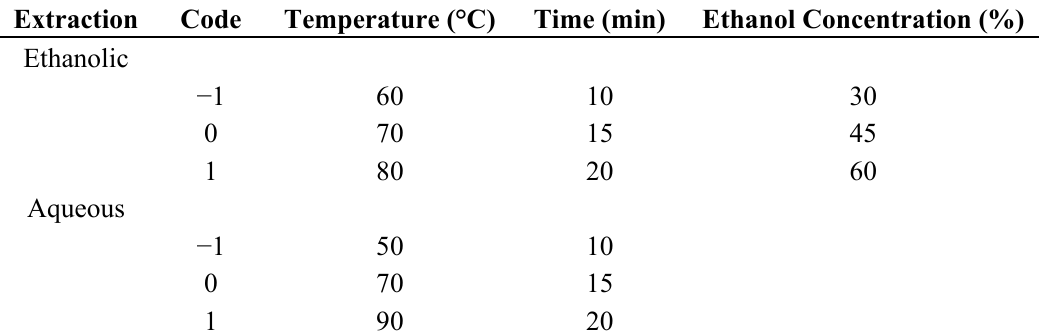
Table 1. Design variable and